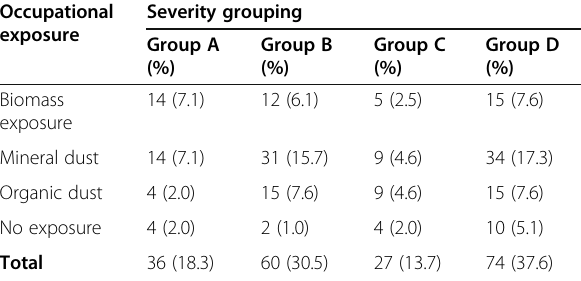
Table 13 Distribution of occupational exposure with severity grouping